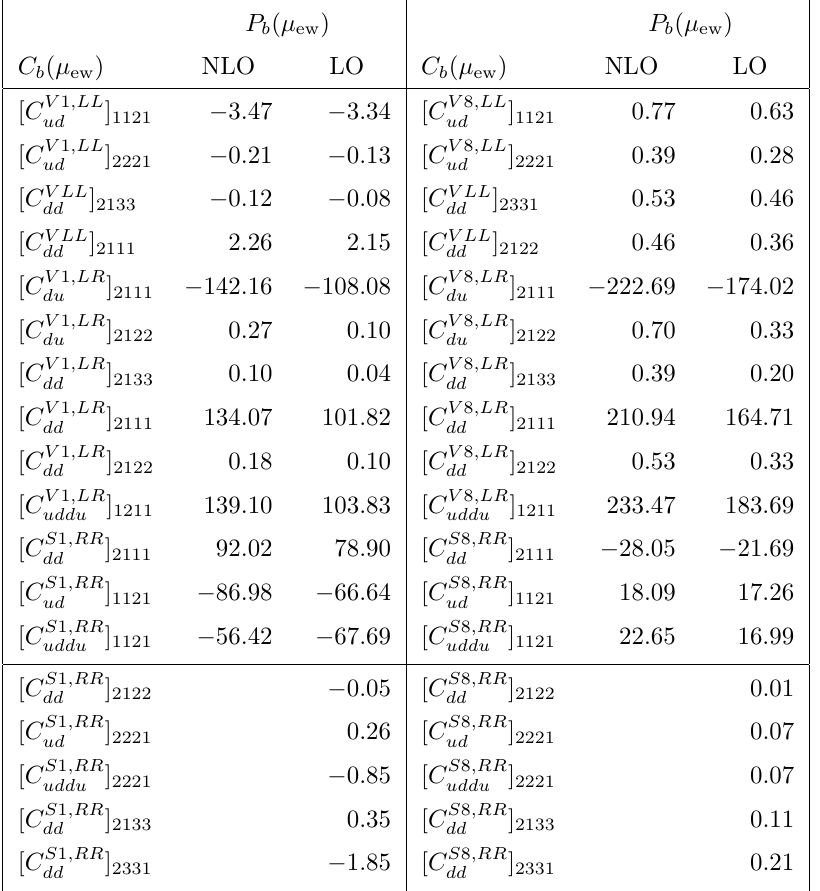
Table 3 . The numerical values for the quantities P b ( µ ew ) that enter in the master formula (2.5) are shown for all JMS WCs contributing to ε 0 /ε for µ with non-vanishing K → ππ matrix elements at NLO in QCD with LO results for comparison. The lower part is due to operators that contribute via mixing into Q